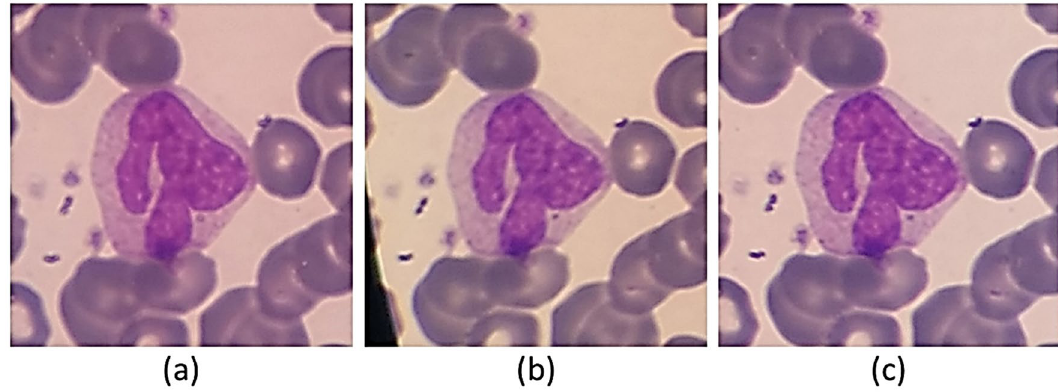
Figure 6. One sample that had been repeated three